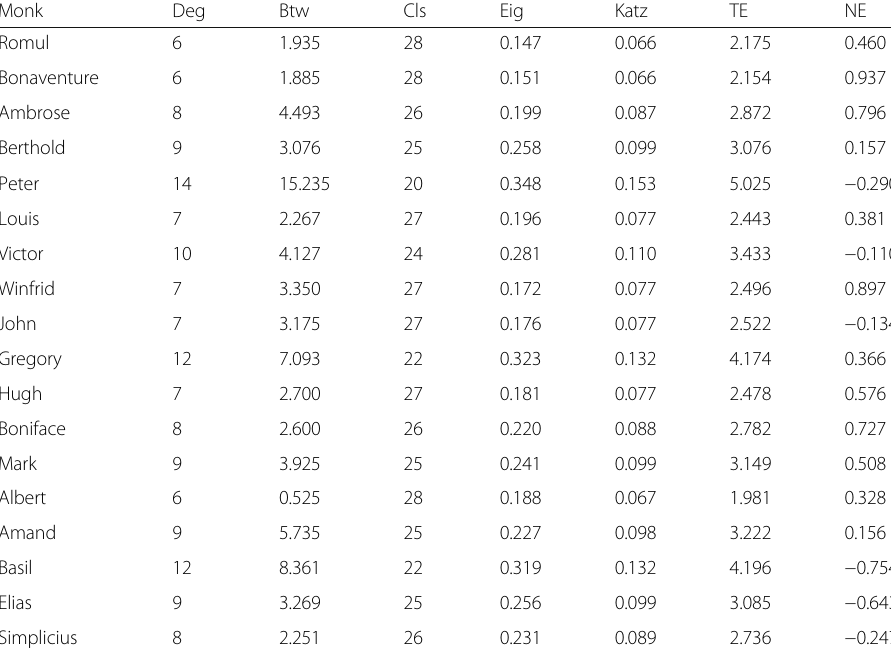
Table 8 Different centrality values calculated on the like-dislike relation network from Sampson ’ s Monastery social network dataset by using centrality measures for unsigned and undirected graphs. Deg, Btw, Cls, Eig and Katz are degree, betweenness, closeness, eigenvector and Katz centralities. TE and NE stand for total effect and net effect as derived from our new methodology. Deg, Btw, Cls and Eig were calculated using Netdraw (Borgatti et al. 2002) Monk Deg Btw Cls